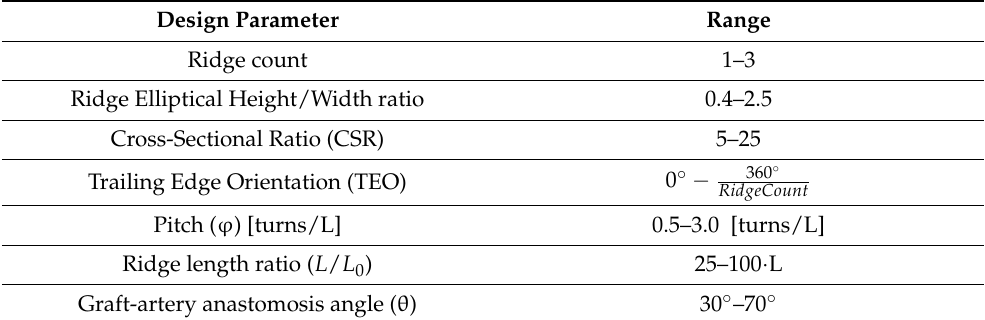
Table 2. The range of design parameters before the parameter correlation study.